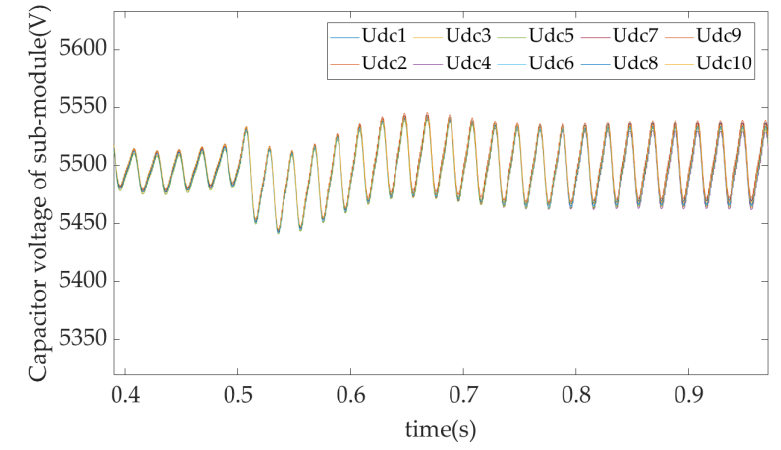
Figure 20. Upper arm capacitor voltages in one leg.